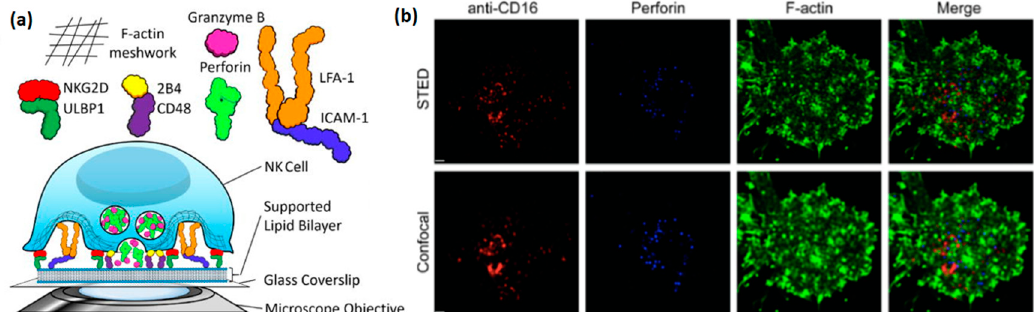
Figure 3. ( a ) Schematic illustration of an artificial immune synapse between NK cell and supported lipid bilayer. Reproduced with permission from Reference [32]. The bilayer includes incorporated ligands recognized by NK cell receptor. The planar interface between the cell membrane and the bilayer enables facile microscopic imaging of the synapse. ( b ) STED imaging of NK synapse on supported lipid bilayer. NK cells were activated on lipid bilayer with incorporated anti-CD16 (red), fixed, permeabilized, and stained with perforin (blue), and anti-(F-actin) (green). Scale bar: 1 µm. Reprinted with permission from Reference [31].